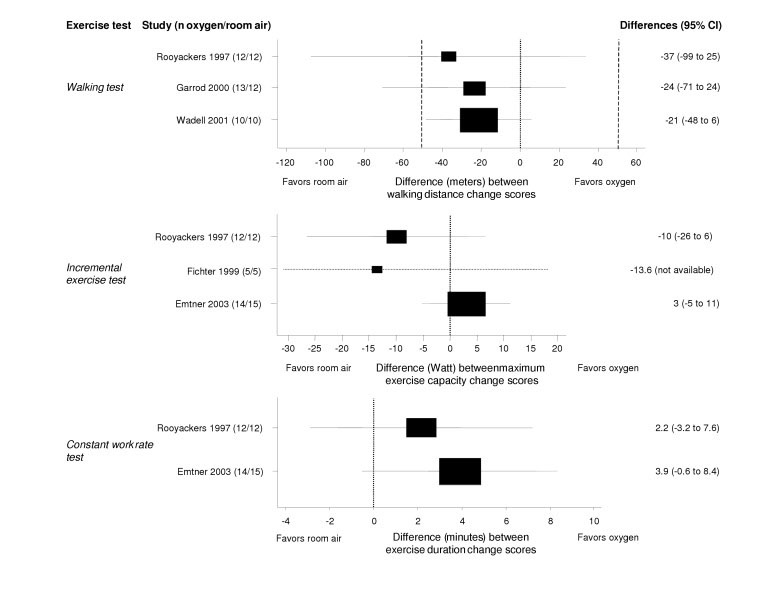
Effect of supplemental oxygen on exercise capacity. The forest plot shows the results from five trials comparing respiratory rehabilitation with and without oxygen. Walking tests, incremental and constant work rate exercise tests were used to assess the additional effect of supplemental oxygen during exercise. The x-axis represents the difference in change scores between study groups with negative values favoring exercise on room air and positive values favoring exercise with supplemental oxygen. A difference of 0 means that both study groups changed to the same amount. Boxes with 95% confidence intervals represent point estimates for the difference between the walking distance and maximum exercise capacity change scores (from baseline to follow-up) of the study groups. Dotted lines represent the minimal important difference of the six-minute walking distance (53 meters). On the right of the forest plot, point estimates for differences between groups and 95% confidence intervals are shown.